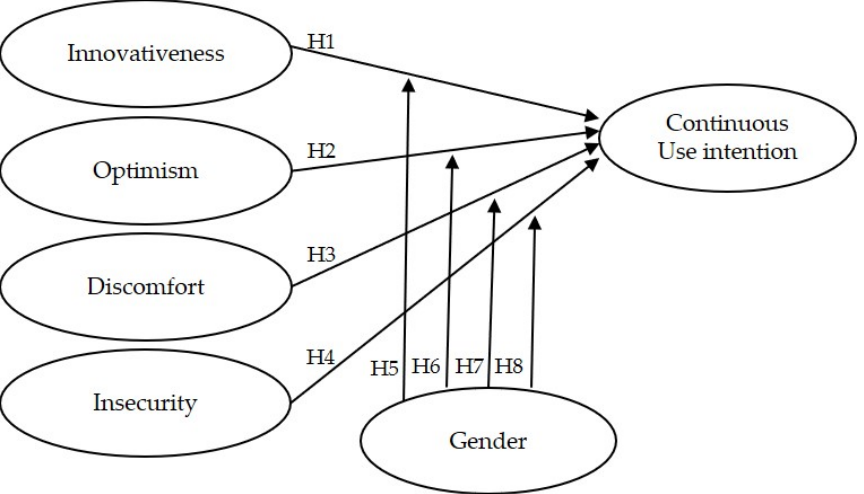
Figure 1. Research